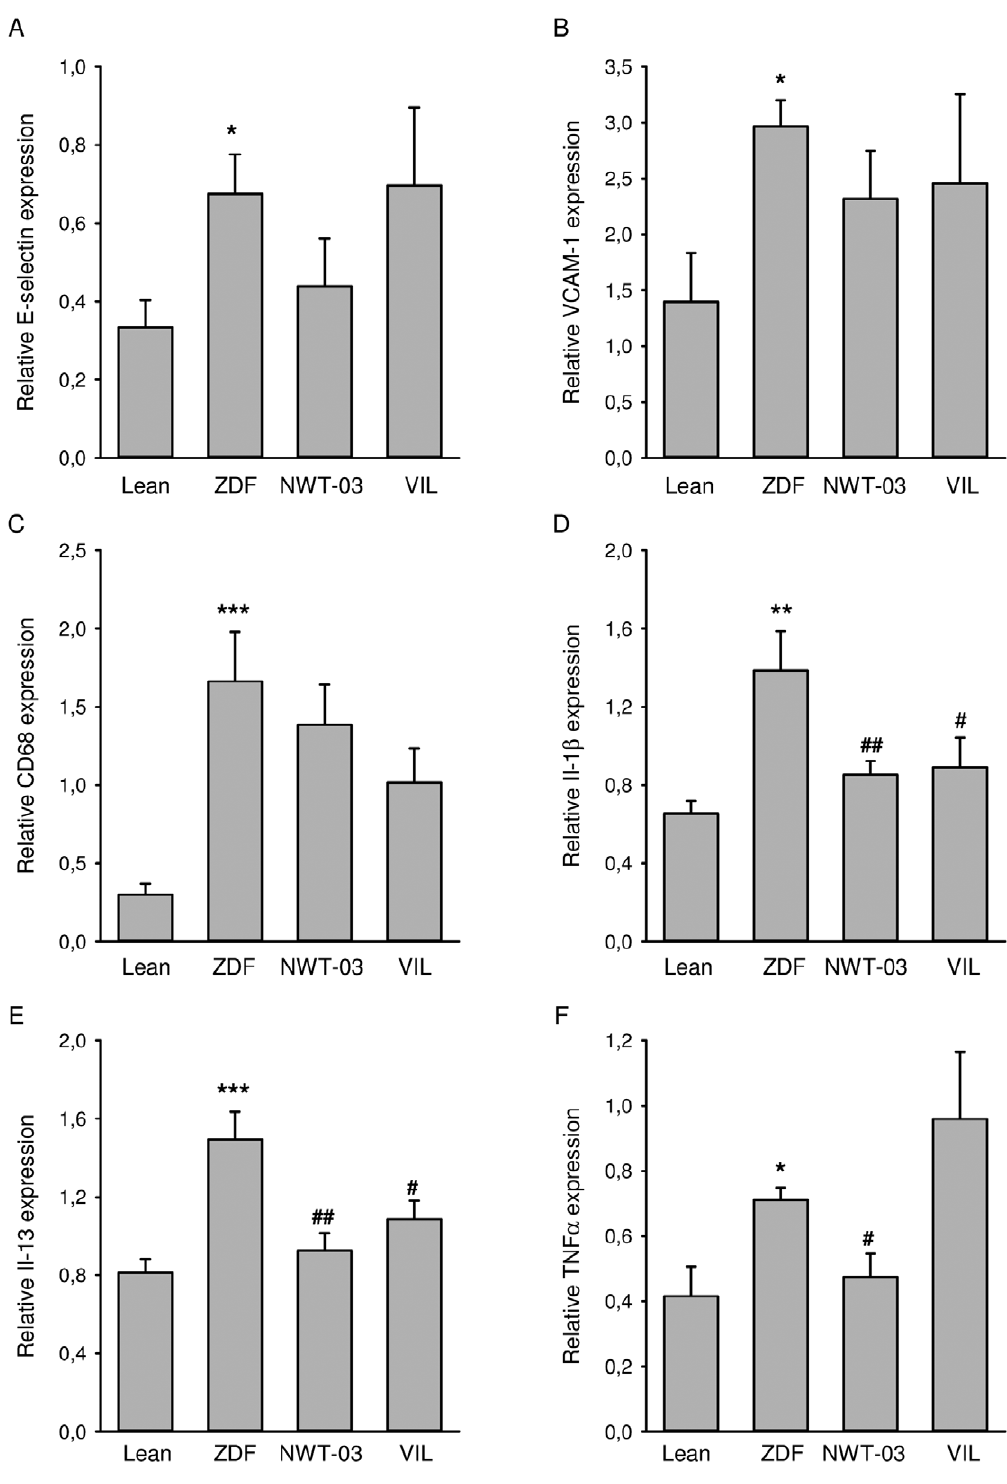
Figure 2. Renal mRNA expression of (A) E-selectin, (B) VCAM-1, (C) CD68, (D) Il-1 b , (E) Il-13, and (F) TNF a . Shown are results for lean controls and untreated ZDF rats, and ZDF rats supplemented with NWT-03 or treated with VIL. Target mRNA levels are expressed relative to those of GAPDH and are presented as means 6 SEMs (*p , 0.05, **p , 0.01, and ***p , 0.001, vs. lean; # p , 0.05 and ## p , 0.01 vs. ZDF).